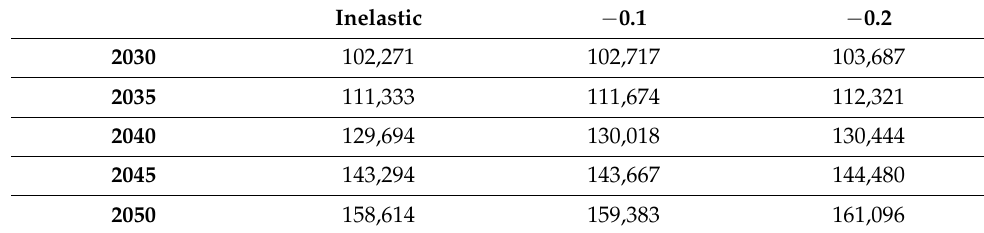
Table 6. Variation in the capacity with respect to the inelastic case. Technologies − 0.1 − 0.2 LNG − 5% − 9% Wind − 19% − 20% Solar PV 9% 12% Solar CSP 4% − 1% Storage − 37% − 29% Table 7. Total yearly demand, in GWh, for each level of elasticity. Inelastic − 0.1 −